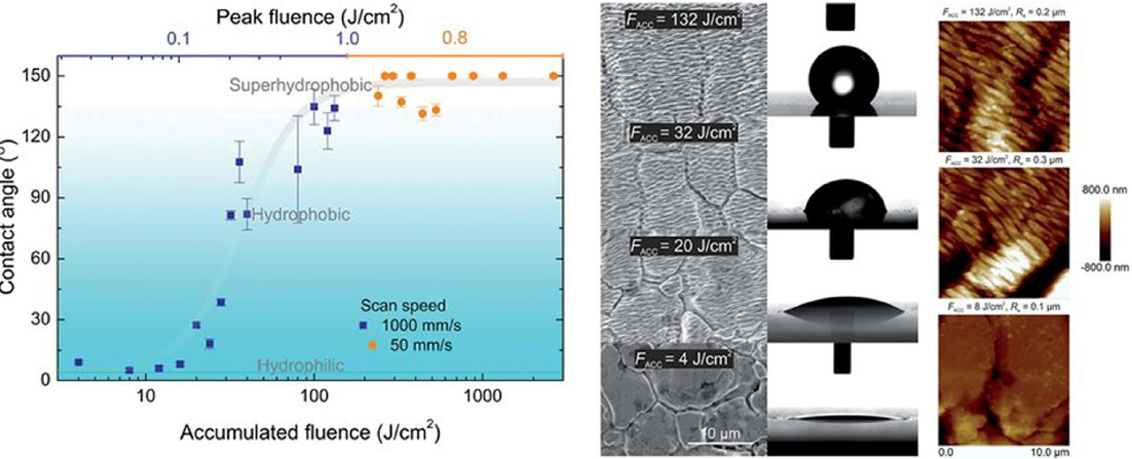
Figure 16. Surface structure and wetting performance of 1.4301 [68]. Available via license: Creative Commons Attribution-NonCommercial 3.0 Unported.